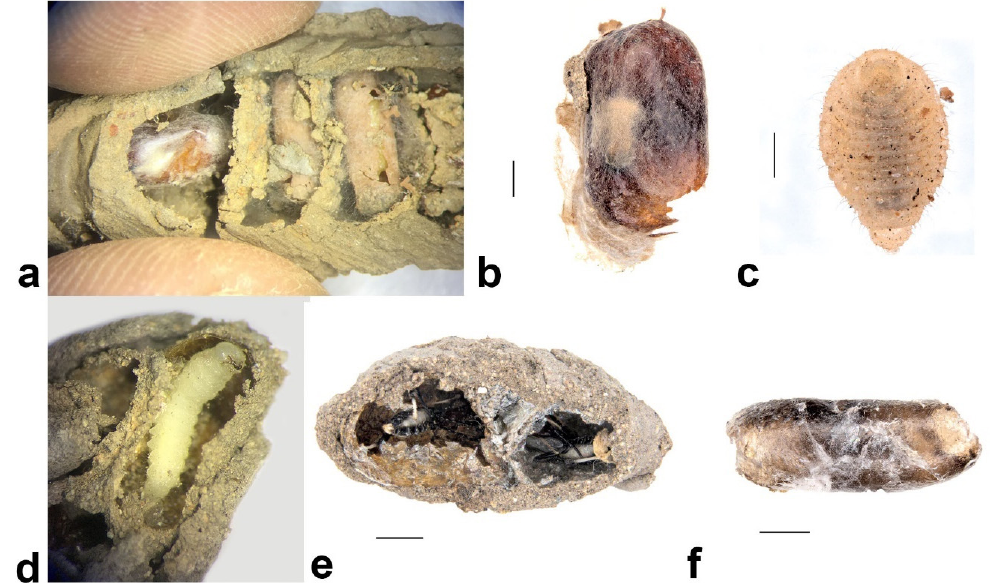
Figure 12. Evidence of the parasitoids of secondary tenants that were found in the S. formosum nest: ( a ) Primeuchroeus reversus in a nest of Pison priscum: cocoon of cuckoo wasp occupied the first cell on the left; ( b ) red bean-like cocoon of Primeuchroeus faustus; ( c ) ventral view of larval Toryminae wasp; ( d ) Gasteruption cinerescens larva in a nest of Pison sp.; ( e ) two nearly emerged adult G. cinerescens in a nest of Hylaeus nubilosus , with visible cellophane coatings, assuming their host is Hylaeus nubilosus; ( f ) brown cocoon of Phrudus sp. Scale bar = 1 mm. Phrudus sp. (Hymenoptera: Ichneumonidae) Two Phrudus ichneumonid wasps were found in a two-cell nest occupied by Pison sp. (Figure 13c). Adults died inside the slender brown pupal case (Figure 12f).